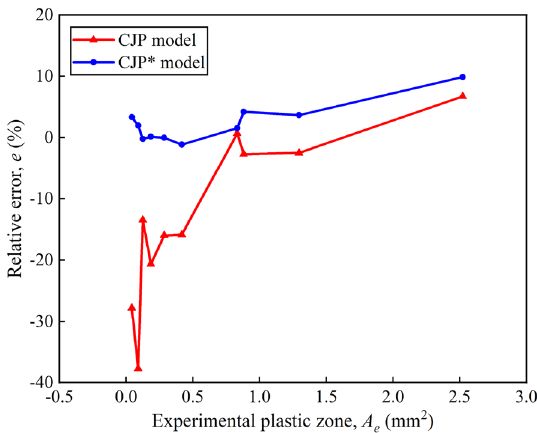
Figure 10 Relationship between the area of the experimental plastic zone and the stress intensity factors K CJP, max and K CJP*,